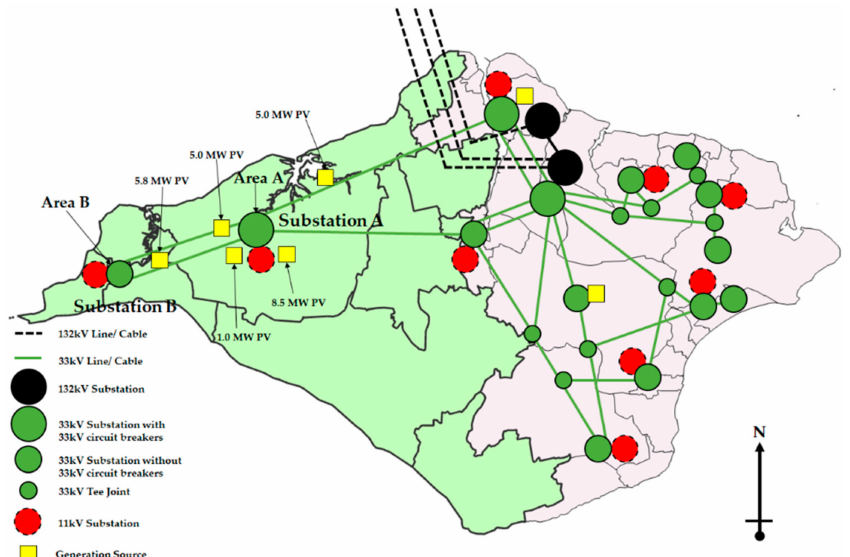
Figure 3. Isle of Wight (IoW) electrical distribution system-network map. The IoW study area is highlighted in green. Locations of assets and routes of overhead lines, underground cables and submarine cables are approximate indications for information only. PV—Photovoltaic, MW—Megawatt, kV—Kilovolt. Image produced using data from Grontmij (2010)